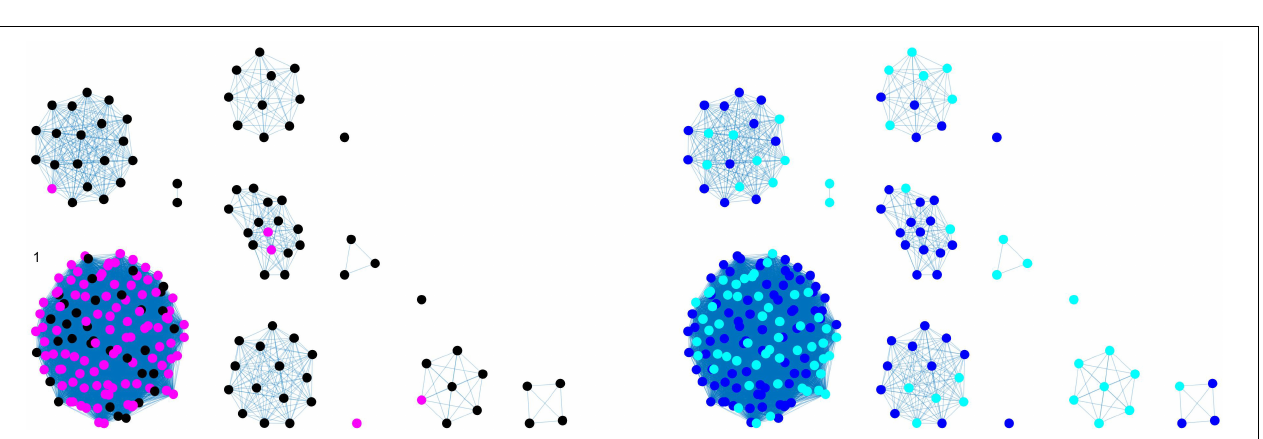
FIGURE 1 | Clustering results (force-directed graph drawing algorithm) obtained by SNP distance matrix, where different node colors represent different sources (left) and different countries of origin (right) . Legend for left-hand figure: pigs, red; broilers, blue; cattle, yellow; ducks, cyan; layers, black. Legend for right-hand figure: purple, Denmark; green, Germany; light blue, others; orange, United Kingdom; yellow, Ireland.